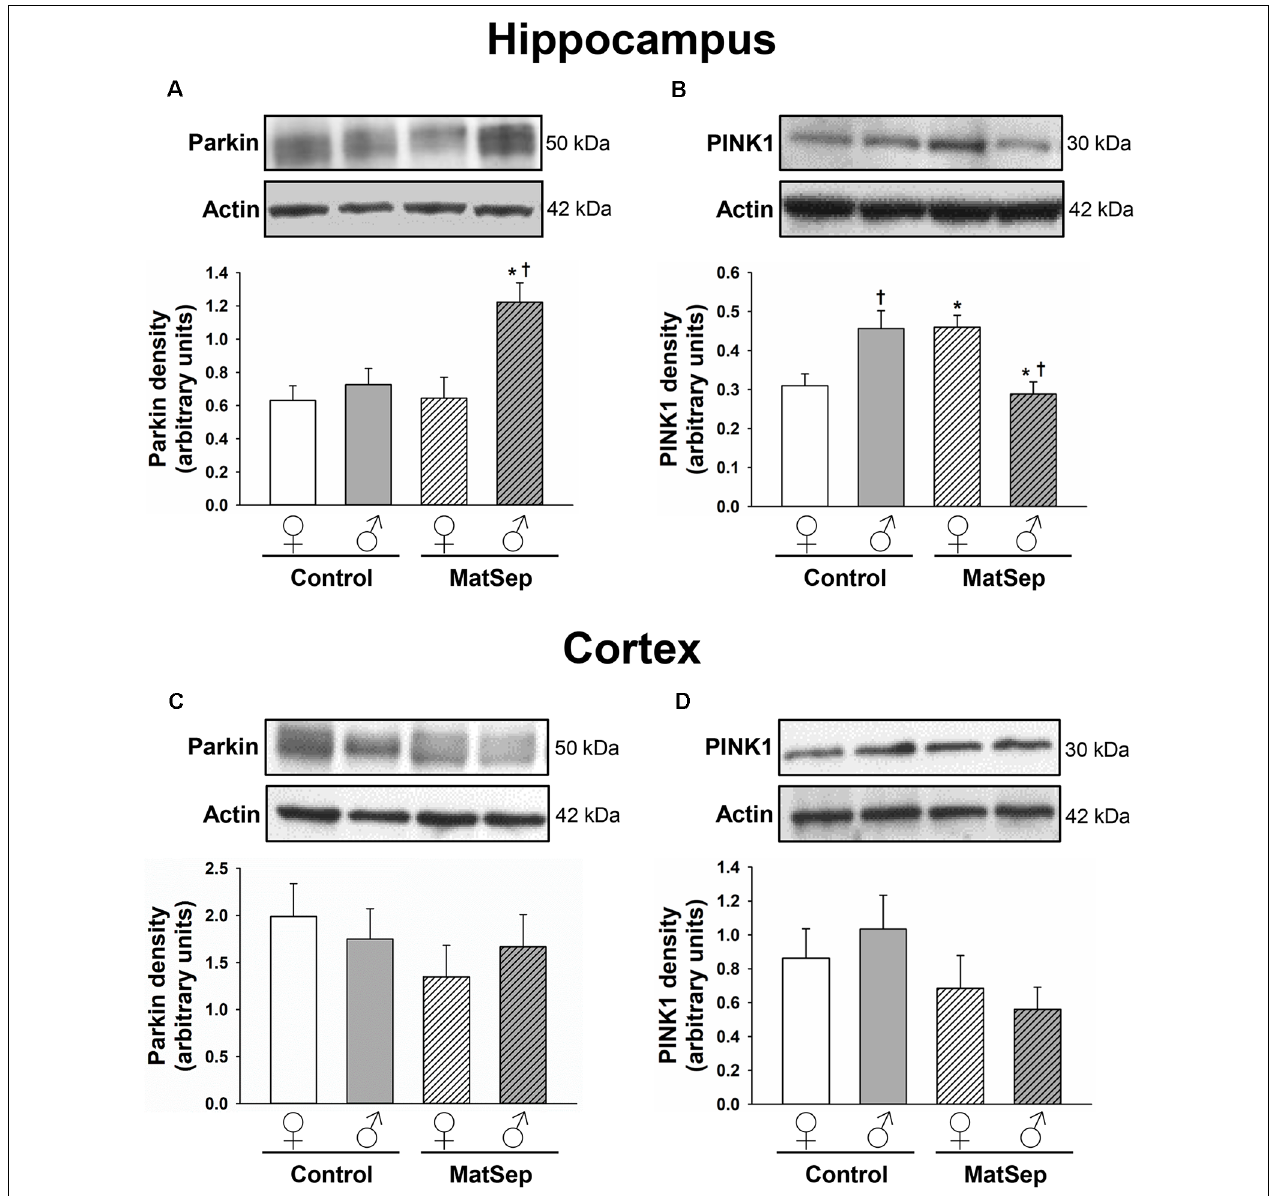
FIGURE 3 | Immunoblot analysis of mitophagy proteins from hippocampal and cortical homogenates from adult rats subjected to MatSep. Panels above each graph show representative blots for (A,C) parkin and (B,D) PINK1. Bar graphs represent densitometric analysis of protein expression normalized to actin and averaged over at least three separate blots. * p ≤ 0.05 vs. same-sex Controls; † p ≤ 0.05 when comparing between